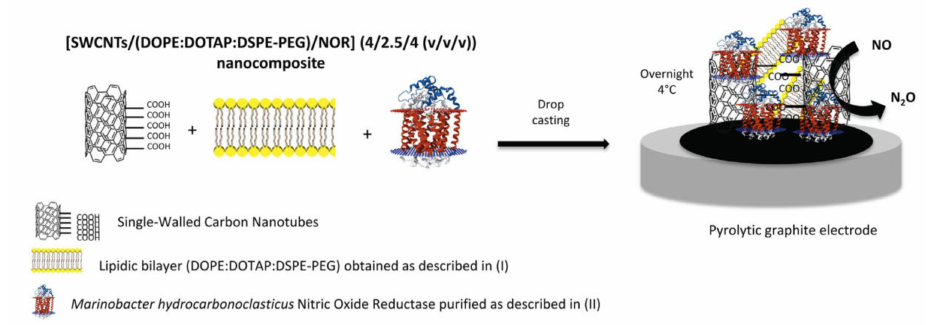
Figure 7. Scheme of nitric oxide biosensor construction. Reprinted from [90] with permission from